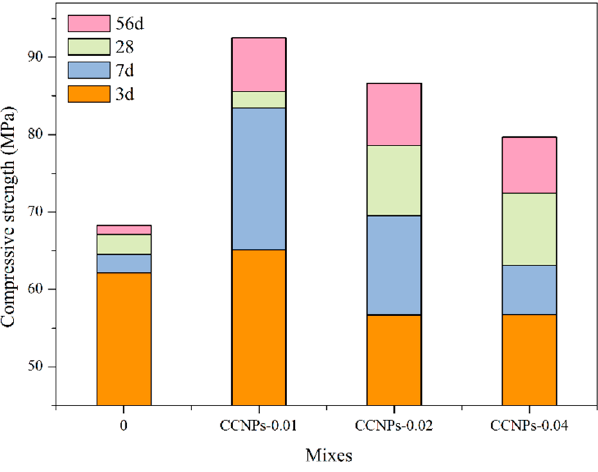
Figure 8. Compressive strength diagram of cement pastes with different amounts of CCNPs.